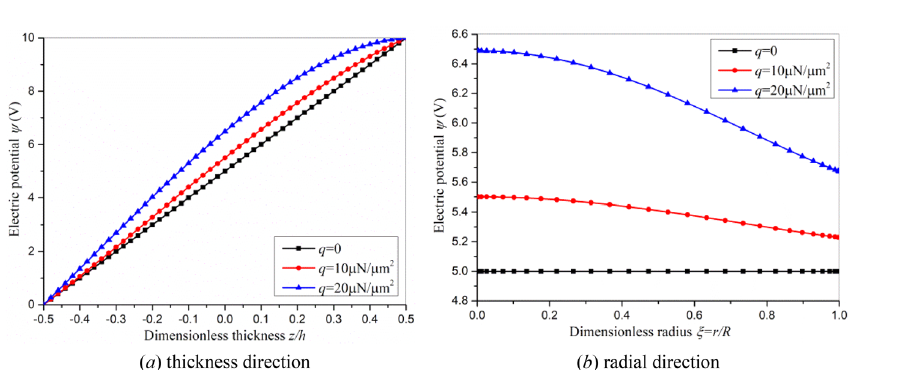
Figure 6. The distribution of electric potential with V 0 =10 V ( a ) thickness direction, ( b ) radial